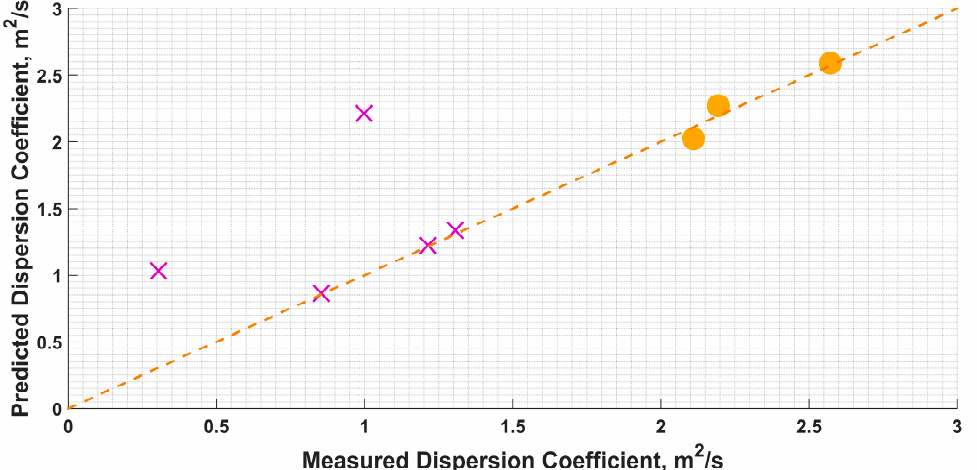
Figure 8. Comparison of values predicted by Equation (8) and those in the validation set. The orange points represent the field experiments and the purple x represent the numerical values.